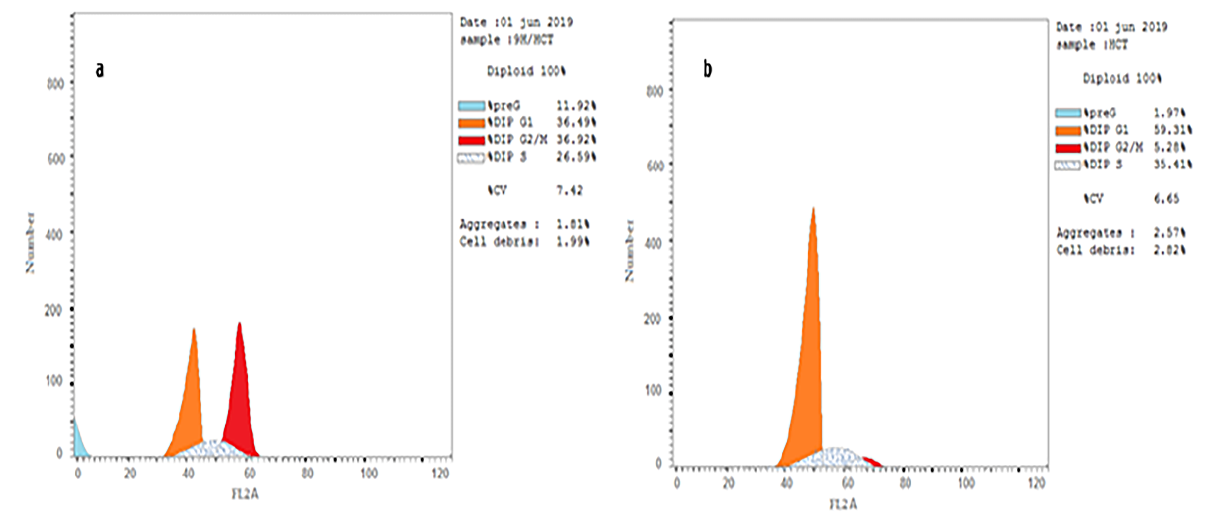
Table 9. Cell cycle analysis after incubation with 7H and 9H. Figure 17. Flow cytometry analysis of cell cycle. ( a ) HCT treated with 9H, ( b ) HCT untreated control. Comparing both curves, it is clear that 9H markedly decreased percentage of cancer cells in G1 phase, thus it has an antiproliferative effect, while it increases the percentage of cells in the G2/M phase, thus it causes cell cycle arrest in G2 Figure 17. Flow cytometry analysis of cell cycle.